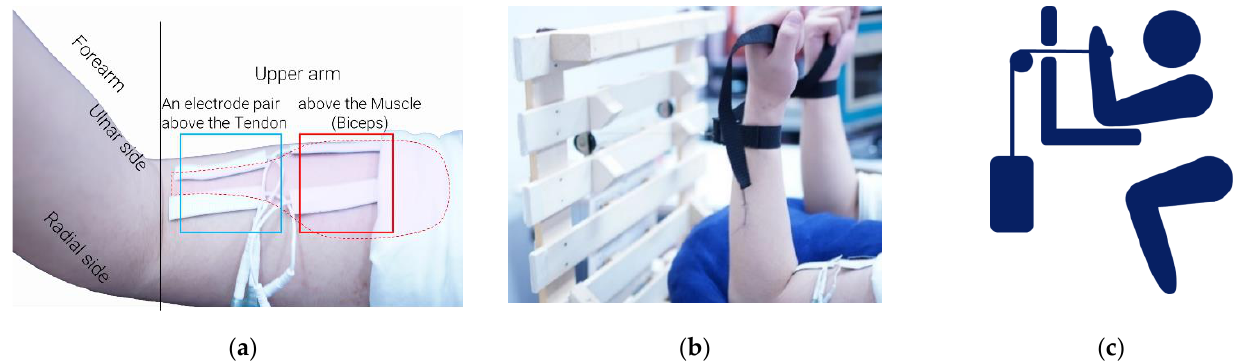
Figure 1. ( a ) Electrodes’ position. A pair of electrodes is put above the biceps muscle of the left arm, and the other pair is put over the tendon and the junction between the muscle and tendon. ( b ) Experimental setup for comparison of force sensation. ( c ) A conceptual side view of ( b ).